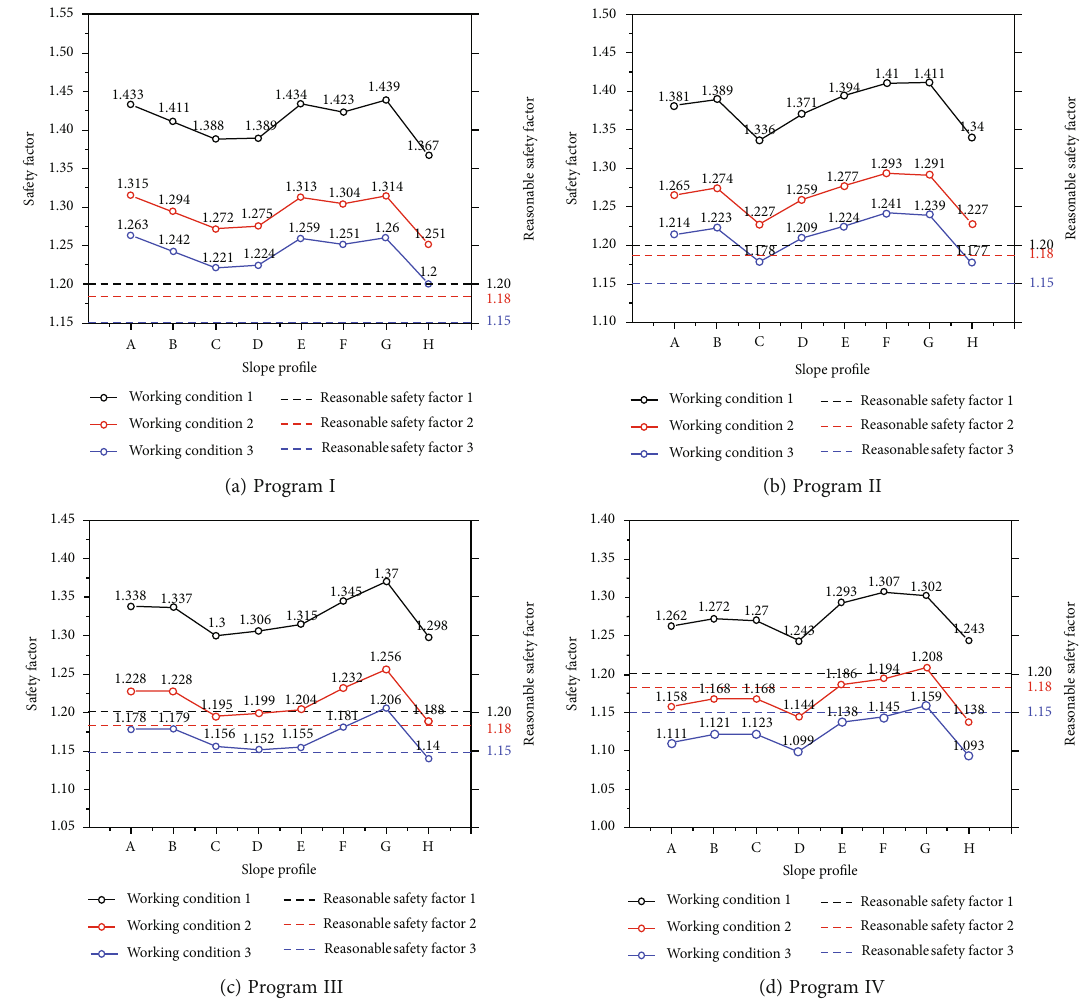
Figure 5: Janbu method to calculate the slope safety factor.